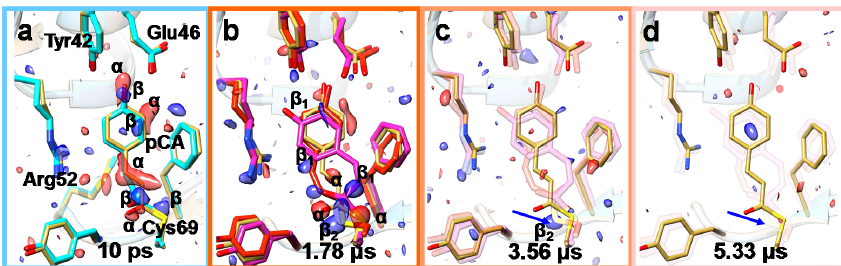
Figure 6. Results of a pump–probe experiment on photoactive yellow protein (PYP) by Pandey et al., 2019. Demonstration how the laser excited volume leaves the X-ray interaction region. After 3.56 µ s, the signal vanishes. Difference electron densities in red ( − 3 σ ) and blue (3 σ ). ( a ) 10 ps pump-probe delay with features α (negative) and β positive. Blue structure: PYP in cis configuration. ( b – d ): microsecond time-delays measured by subsequent X-ray pulses show how the laser excited volume is transported out. Features α and β differ from ( a ). The features are interpreted by the mixture of pR1 (magenta) and pR2 (red) intermediates which are typical for PYP on this time scale. Feature β 2 (arrow) remains up to 3.56 μ s, and is completely absent at 5.33 μ s. Figure from Pandey et al. [66]. Although the experiment on PYP was a pump–probe experiment, it already suggests ways how